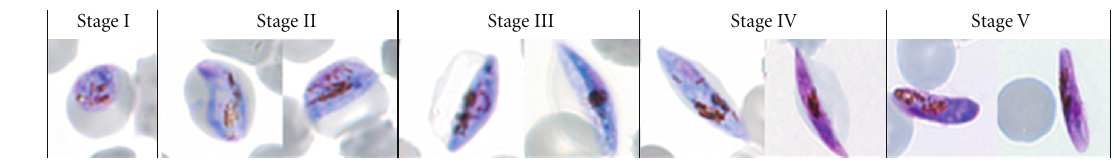
Figure 2: In vitro P. falciparum gametocytes obtained with this optimized protocol. Gametocytes stages (maturity) based on the Carter description: stage I, stage II, stage III, stage IV, and stage